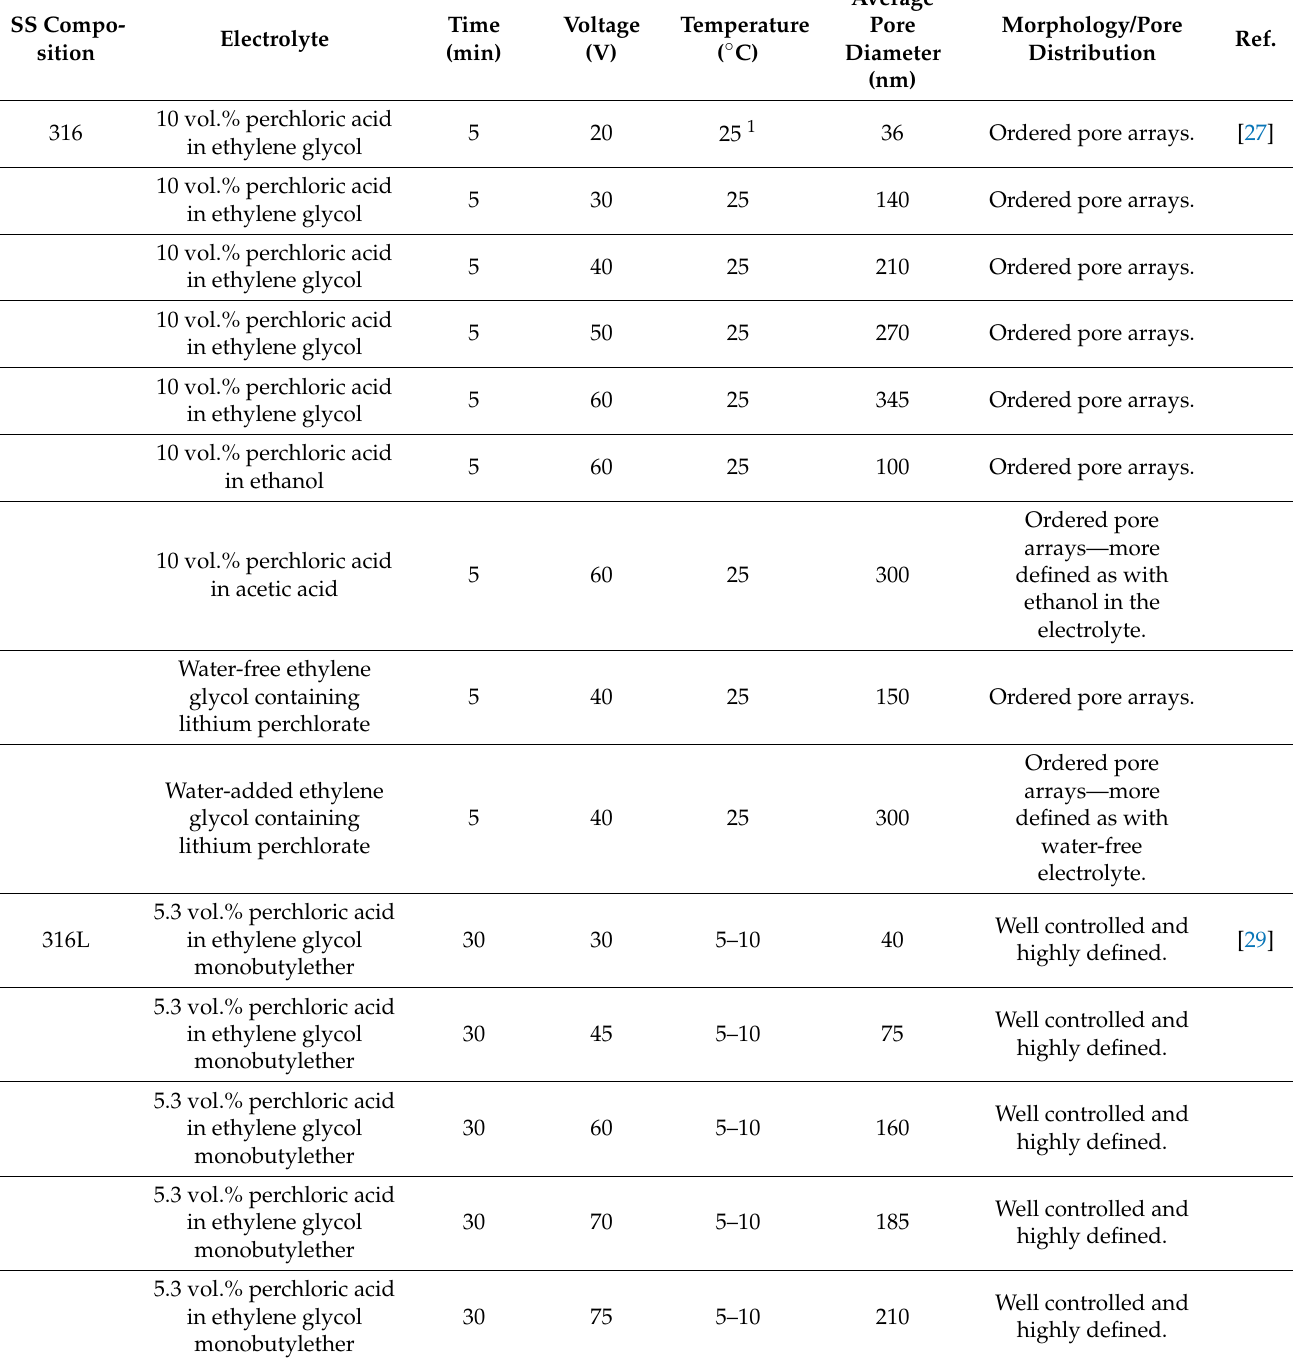
Table 1. Review of the experimental parameters and results reported by various